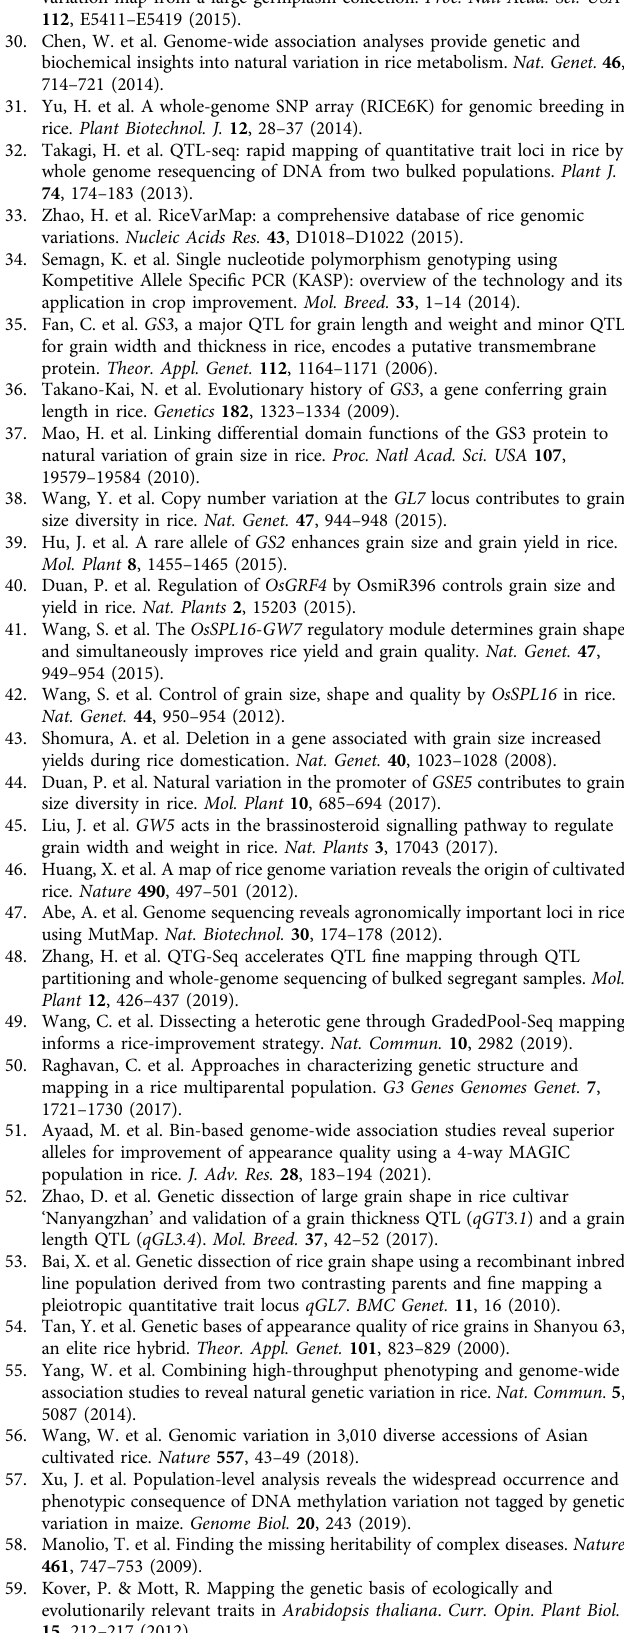
Supplementary Information fi le. The SNP data of the mini-core collection can be retrieved from http://ricevarmap.ncpgr.cn/download/. Accession codes of all genes or alleles reported in the study are available in GenBank: cDNA of GS3-5 in Zhimali and Heen GW, MW808603; cDNA of GS3-6 in SYB5, MW808604; genomic DNA of GL1 in WZ1, MW804343; genomic DNA of GL1 in 9311, MW824660; genomic DNA of GL1 in Zhonghua 11, MW824661; genomic DNA of GW5.1 in Ikasan438, MW800744. DNA deep sequencing for two DNA pools from Cross 4 for grain length and two DNA pools from Cross 7 for grain width are deposited in the SRA database of NCBI with accession PRJNA761681 and PRJNA761576, respectively. Source data are provided with this